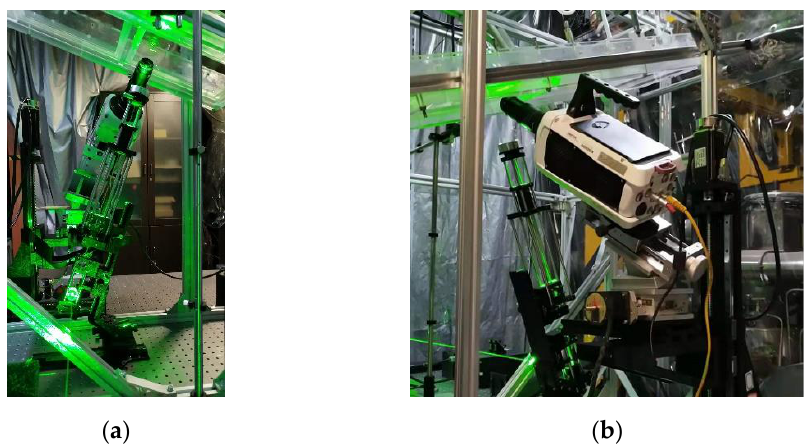
Figure 3. Photographs of PIV/PLIF measurement experiments. ( a , b ) were photos corresponding to schematic diagrams in Figure 2.